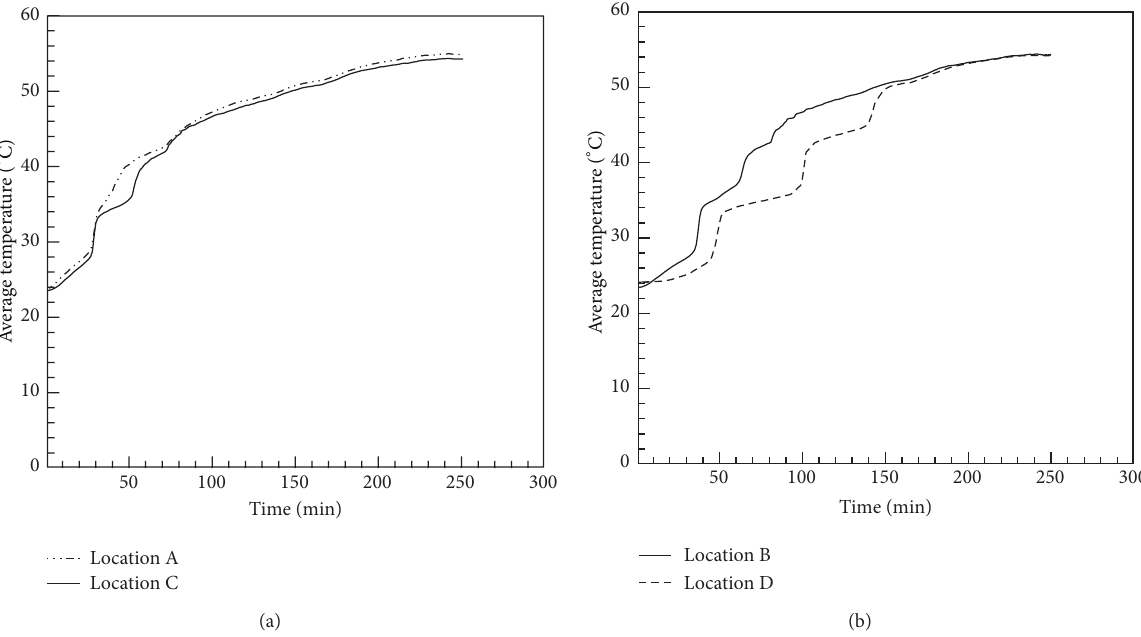
Figure 7: Comparison of average temperature profile in simple heat exchanger in two directions: (a) length; (b) depth. The effect of various flow rates on the average temperature profile during melting process for two heat exchangers is shown in Figures 6(a) and